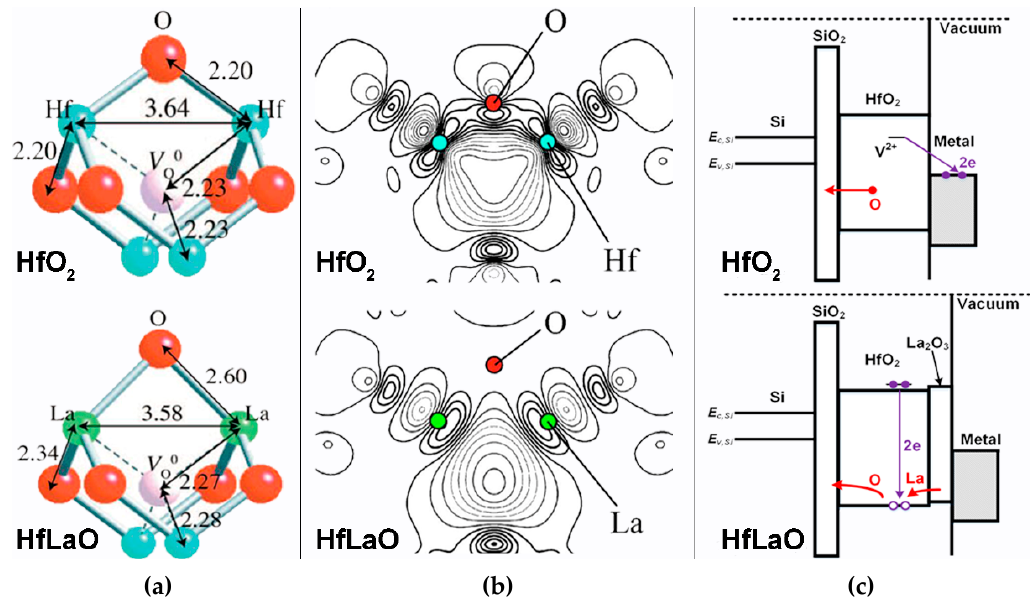
Figure 11. For HfO 2 and HfLaO: ( a ) relaxed structure of oxygen vacancies V O [60], ( b ) contour plot of wave function corresponding to the V O -related gap states [60], and ( c ) schematic band diagram showing oxygen vacancies [68].